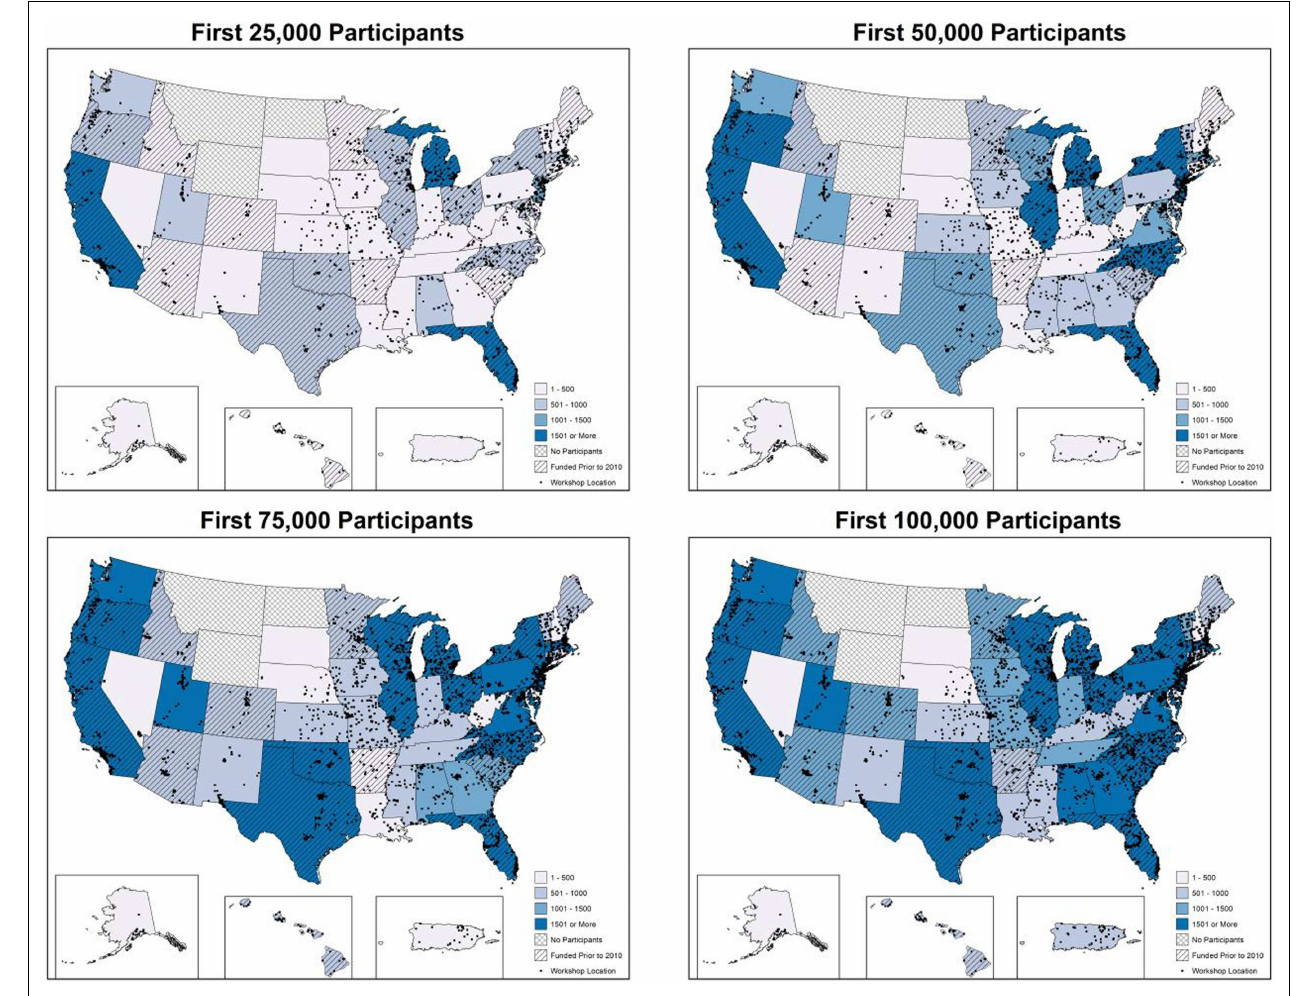
FIGURE 1 | Geospatial distribution of CDSMP workshops and participants by increments of 25,000 participants